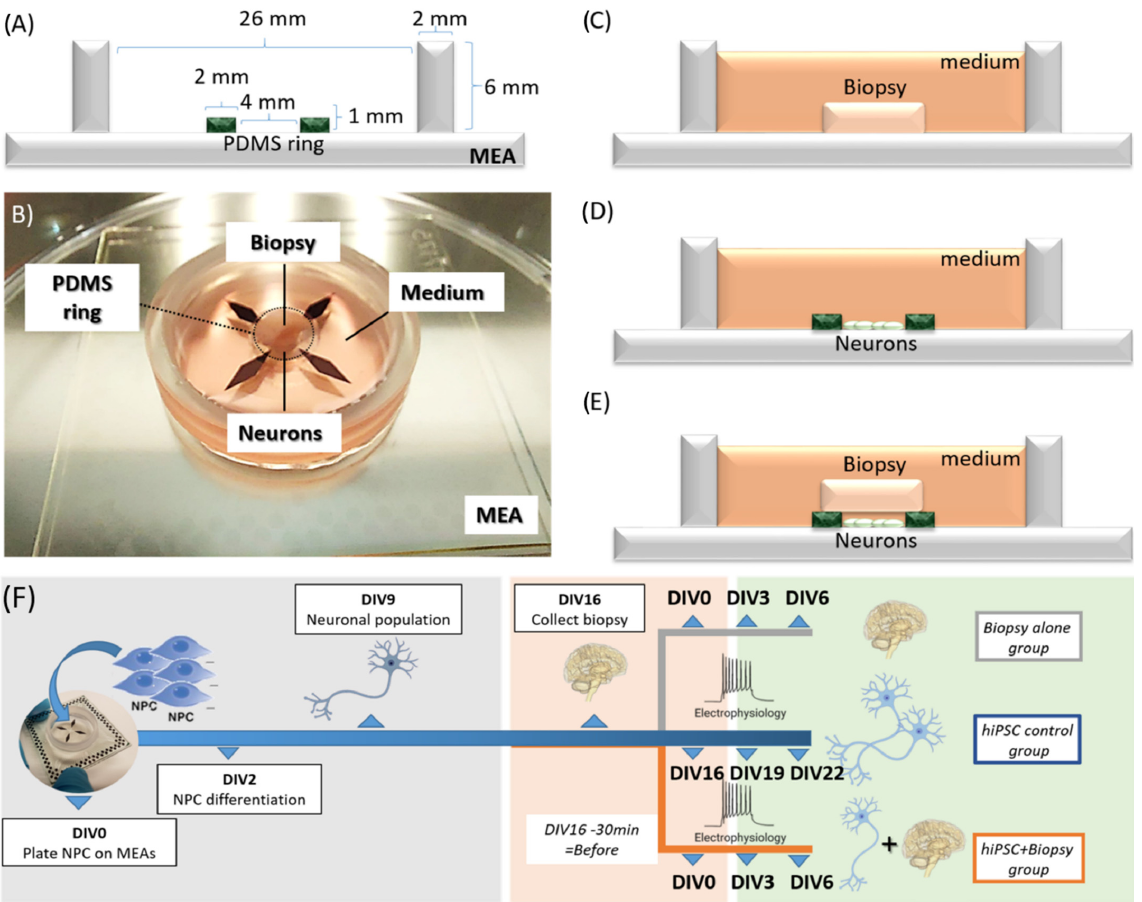
Figure 1. Design of the hybrid brain biopsy plug-hiPSC-derived neuronal cell monolayer model. ( A ) Schematic cross section showing dimensions of the setup, multi-electrode array (MEA) and the PDMS ring. ( B ) Picture of the biopsy plug placed directly on the hiPSC-seeded MEA device. Schematics of the three culturing conditions: ( C ) only the biopsy plug; ( D ) only the hiPSC-derived cortical neuronal cell monolayer; and ( E ) the hybrid model with the biopsy in close contact with the hiPSC-derived neurons. ( F ) Time line of the experiments showing the days in vitro (DIV) for the hiPSC-derived neuronal cultures before the biopsy collection (grey), when the biopsy is collected and assembled (DIV16 neuronal culture/DIV0 biopsy culture, pink) and for the experiment (DIV19 to 22 neuronal culture/DIV3 to 6 biopsy culture, green). Data points stating “Before” represent the day of the biopsy assembly (DIV16) minus 30 min. Measurements were taken “before” to characterize both the hiPSC neuronal culture alone and the biopsy plug alone before the biopsy was mounted on the neuronal cell